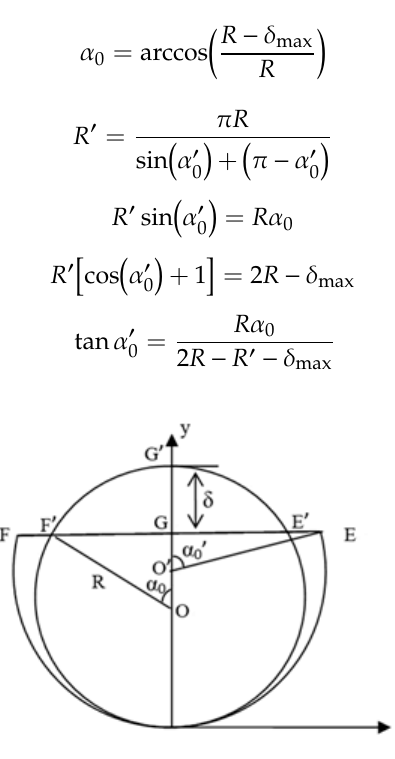
Figure 5. Section in the II-II direction.